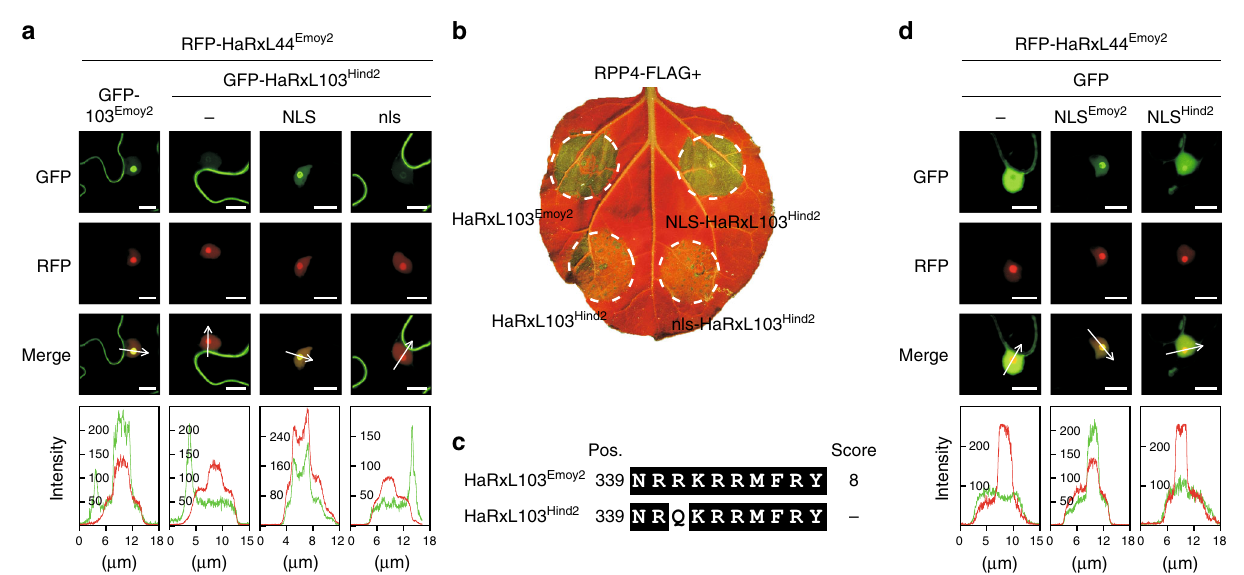
Fig. 4 The mutation in HaRxL103 Hind2 affects in planta subcellular localization. a Subcellular localization of GFP-HaRxL103 Emoy2 (GFP-103 Emoy2 ), GFP- HaRxL103 Hind2 , and NLS- or nls-fused GFP-HaRxL103 Hind2 . GFP-tagged HaRxL103 Emoy2 and HaRxL103 Hind2 variants were transiently co-expressed with RFP-HaRxL44 Emoy2 via agroin fi ltration in N. benthamiana . The upper image is from the GFP channel, the middle image is from the RFP channel, and the lower image is the overlay of the GFP and RFP channels. Fluorescence intensity pro fi le (GFP, green; RFP, red) across the white arrow was performed using the analyzing software (Leica, bottom). Scale bars, 10 μ m. b HR cell death phenotypes when co-expressed of HaRxL103 Emoy2 and HaRxL103 Hind2 variants with RPP4 in N. benthamiana . The leaves inoculated with Agrobacterium containing the indicated gene constructs were photographed under UV at 3 dpi. c A predicted NLS sequence from HaRxL103 Emoy2 and HaRxL103 Hind2 . Prediction of NLS in HaRxL103 Emoy2 or HaRxL103 Hind2 was done in cNLS Mapper. Position of predicted NLS and score for the prediction are indicated. Identical sequences are indicated in white on black. d Subcellular localization of GFP- fused predicted NLS from HaRxL103 Emoy2 (NLS Emoy2 ) and HaRxL103 Hind2 (NLS Hind2 ). GFP, GFP-NLS Emoy2 , and GFP-NLS Hind2 were transiently co- expressed with RFP-HaRxL44 Emoy2 via agroin fi ltration in N. benthamiana . Imaging was performed as described in ( a ). Scale bars, 10 μ